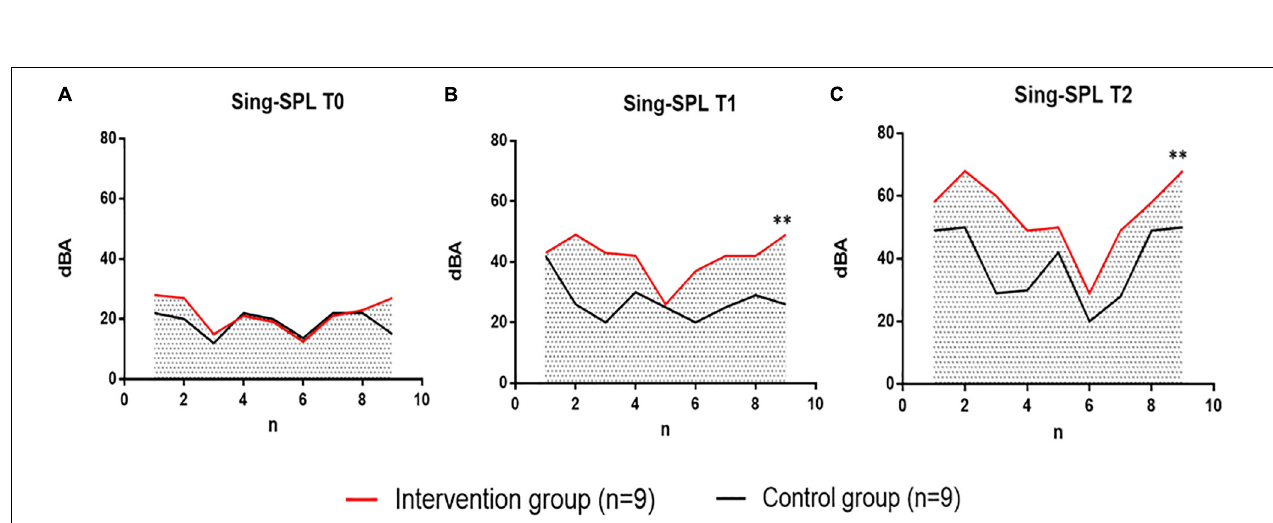
FIGURE 5 | Comparison of Sing-SPL at three time points: T0, T1, and T2 between the intervention group undergoing VIT and the control group that performed respiratory phonation training. The intervention group is indicated in red. Control group, black indicates. (A) Individual difference distribution of Sing-SPL values at T0 time points between patients in the intervention group ( n = 9) and patients in the control group ( n = 9). (B) Individual difference distribution of Sing-SPL values at T1 time points between patients in the intervention group ( n = 9) and patients in the control group ( n = 9). (C) Individual difference distribution of Sing-SPL values at T2 time points between patients in the intervention group ( n = 9) and patients in the control group ( n = 9). dBA, decibel; n, the number of participants; T0, baseline; T1, after 6 weeks; T2, after 12 weeks. ** p < 0.01, with significant differences between groups.